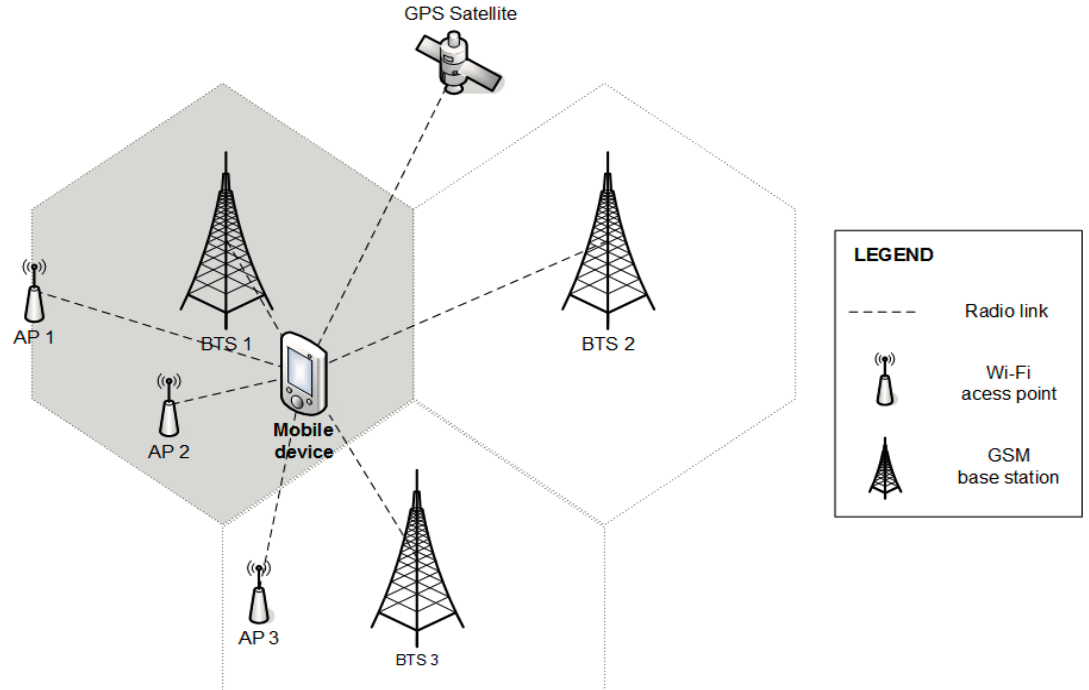
Figure 2. Example of an